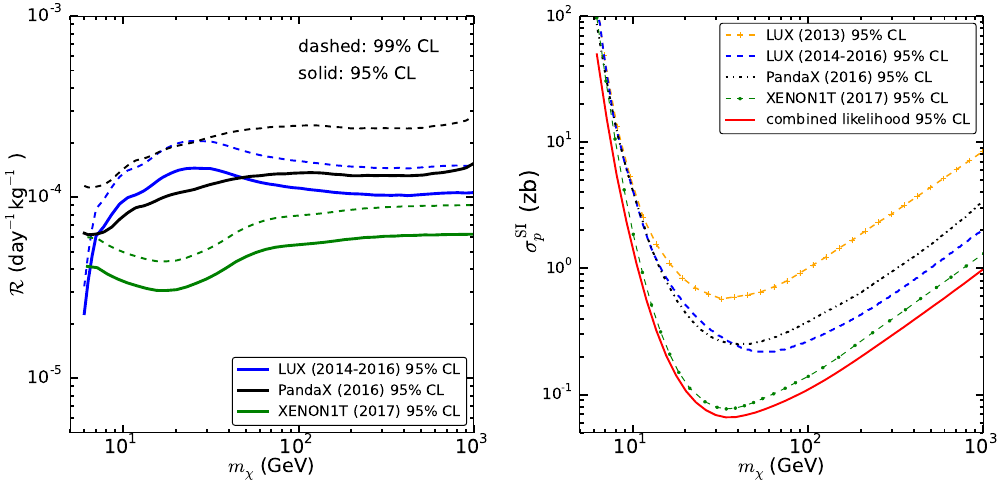
Figure 1 . Left panel: upper limits of the event rate R as a function of m (cid:31) at 95% (solid) and 99% (dashed) CL, for PandaX (black), LUX (blue), and XENON1T (green). Right panel: the 95% CL upper limits of (cid:27) SI for PandaX, LUX, XENON1T, and the combination of these three experiments. p Here, we adopted exactly the same astrophysical setup as used in the experimental computation, the soft-truncated Maxwell-Boltzmann distribution with v 0 = 220 km = s, (cid:26) 0 = 0 : 3 GeV = cm 3 , and v esc = 544 km =